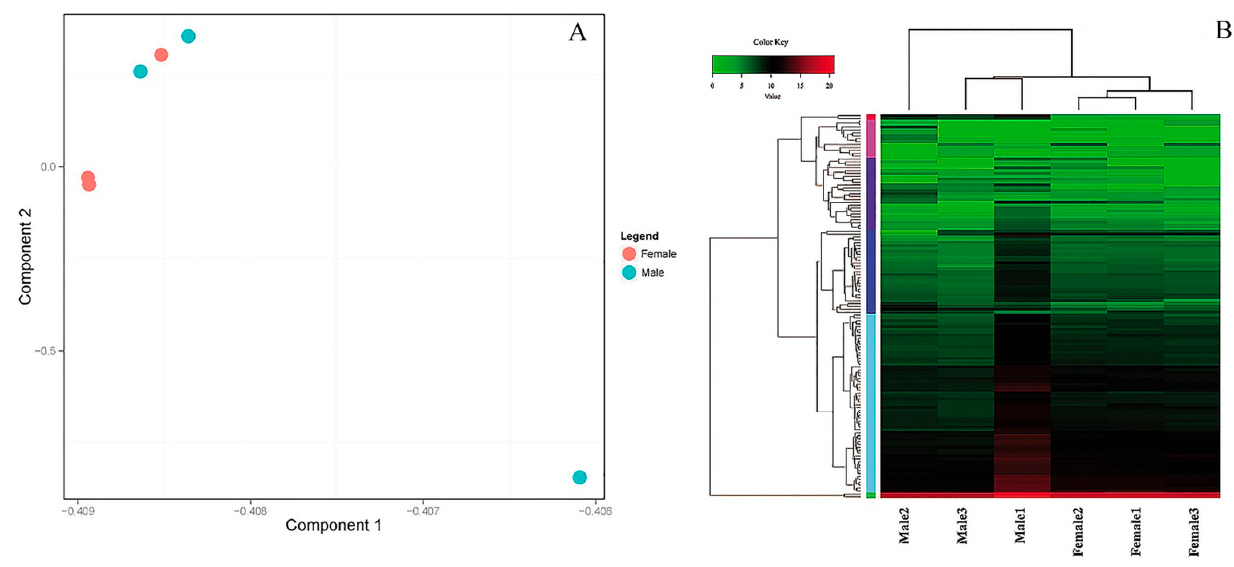
Figure 4. PCA analysis and a heatmap for DGEs. Panel ( A ) shows very small differences between the female and male blood transcriptome in the PCA. Panel ( B ) presents the hierarchical clustering of DEGs somewhat differentiated between the female and male transcriptome profiles.